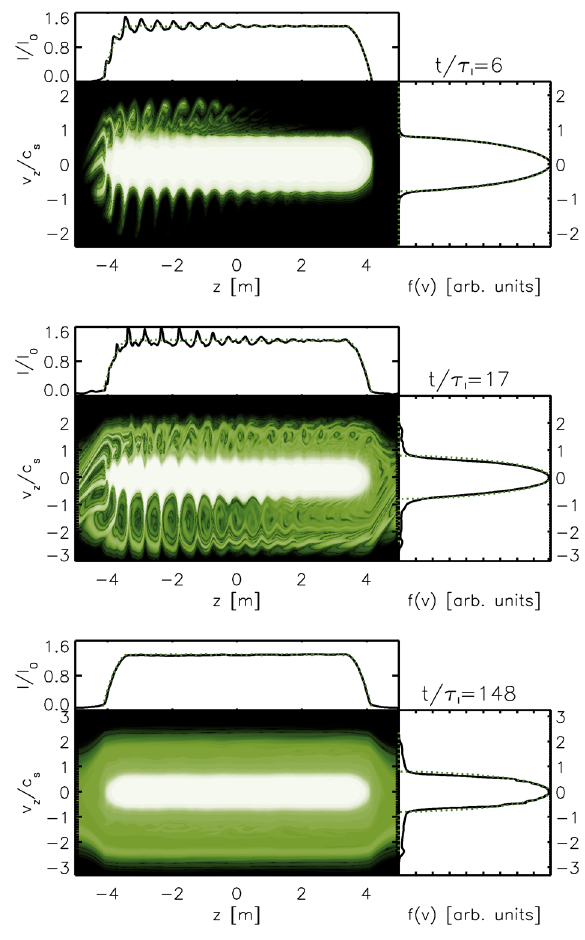
FIG. 12. (Color) Time evolution of the microwave instability in a barrier bucket for U (cid:4) 2 : 0 , V (cid:4) 0 : 3 , and n resolution of the low density phase space regions the contours of ln (cid:1) 1 (cid:2) f (cid:5) are shown and a different color set is used. The green dotted curves represent the initial current profile and velocity